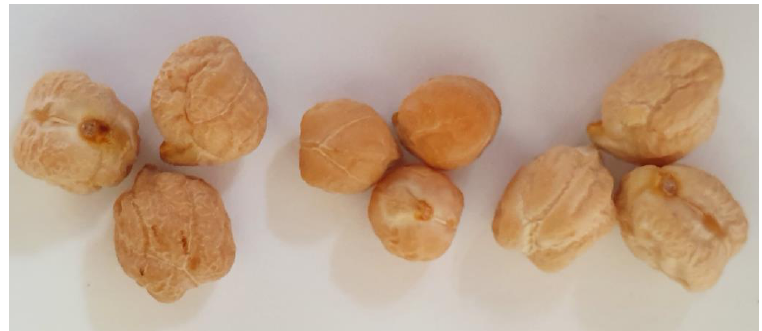
Figure 3. Seeds of a progeny (with two pods per axil and 63 g per 100 seeds, left side) in F 3 derived from intraspecific crosses between Sierra (single-podded, unifoliolate leaf and 46.9 g per 100 seeds, right side) and CA 2969 (double-podded, imparipinnate leaf and 27.4 g per 100 seeds, middle).